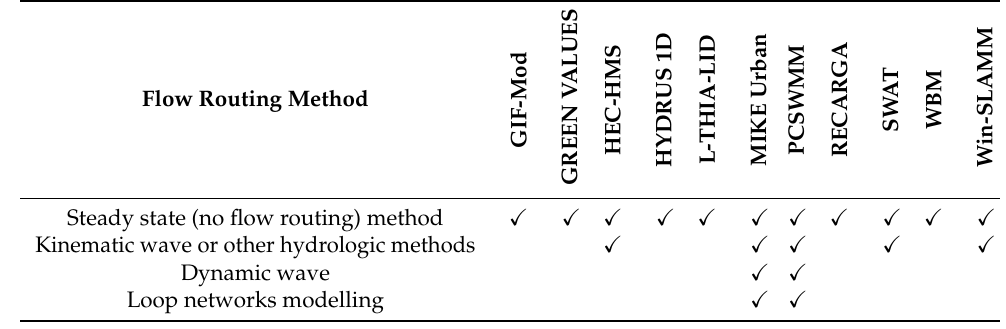
Table 10. Comparing the flow routing method of the selected